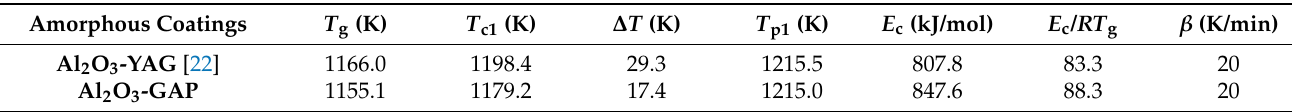
Figure 3. ( a ) DSC curve of the Al 2 O 3 -GAP amorphous coating at the heating rate of 20 K/min; ( b ) initial crystallization activation energy E c (x) obtained by the Kissinger method for some typical amorphous materials reported [22,29–48]. Table 3. A series of evaluation parameters of thermal stability for Al 2 O 3 -YAG and Al 2 O 3 -GAP amorphous